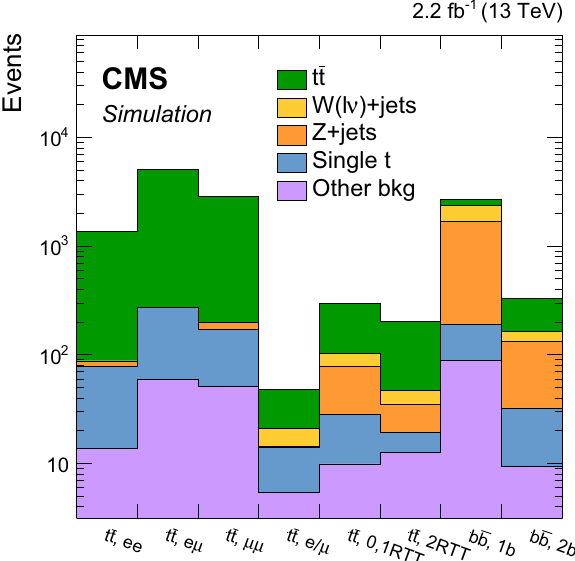
Fig. 3 Simulation-derived background expectations in the tt + p miss and bb + p miss signal T